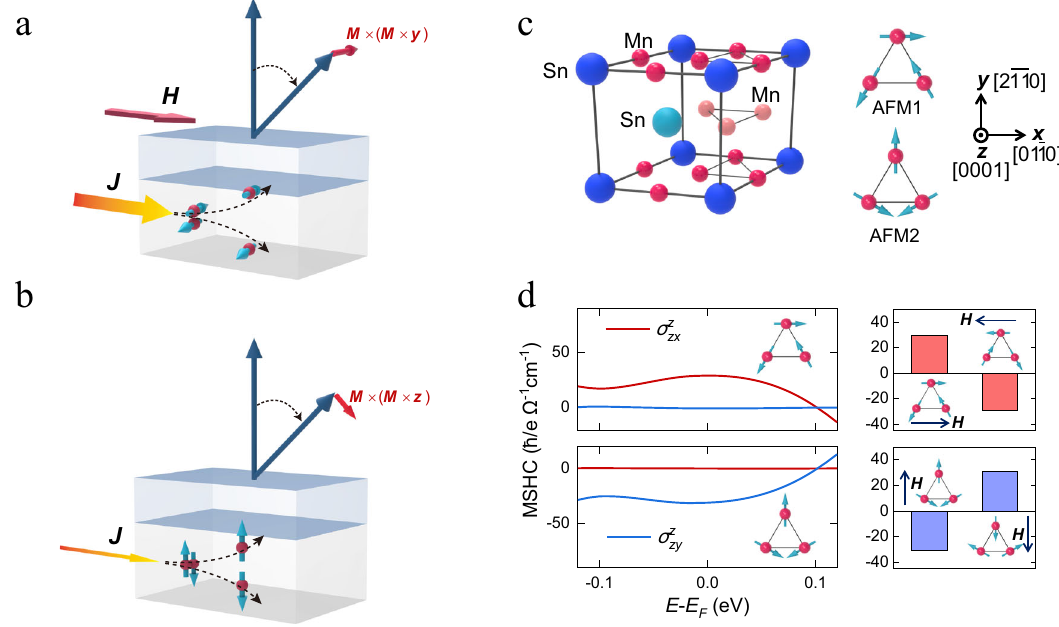
Fig. 1 | Switching of perpendicular magnetization by damping-like SOTs. a A schematic of a conventional bilayer SOT device. An in-plane charge current passes along x direction in the bottom spin source layer, generates an out-of-plane spin current with y -polarized spin through SHE. This spin current exerts an in-plane damping-like torque ~ m × m × y on the perpendicular magnetization in the top fer- romagnetic layer. In this case, a sizable external magnetic fi eld is required for a deterministicswitching,andthechargecurrentrequiredislarge. b Aschematicofa bilayerSOT device supporting the out-of-plane anti-damping torque, wherethe in- plane charge current generates an out-of-plane spin current with z- polarized spin. This spin current exerts an out-of-plane anti-damping torque ~ m × m × z on the per- pendicular magnetization in the top layer to realize a fi eld-free switching, which